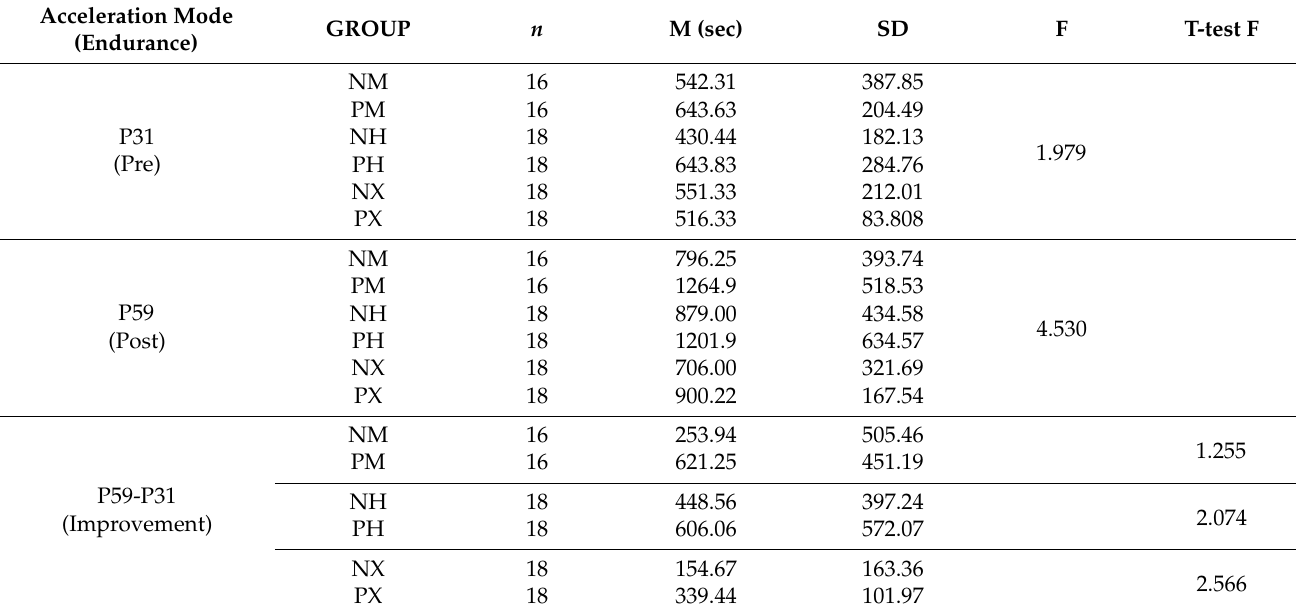
Table 1. Statistical values of latency to fall from the rotarod test at acceleration mode. Values are presented as M (mean, sec) and SD (Standard Deviation). At P31 and P59, significant difference was assessed by One-way ANOVA at P31 and P59. For the improvement assessment, the significant difference was evaluated by independent t -test at P59-P31. N, no probiotics; P, probiotics; M, moderate-intensity exercise; H, high-intensity exercise; X, no exercise.